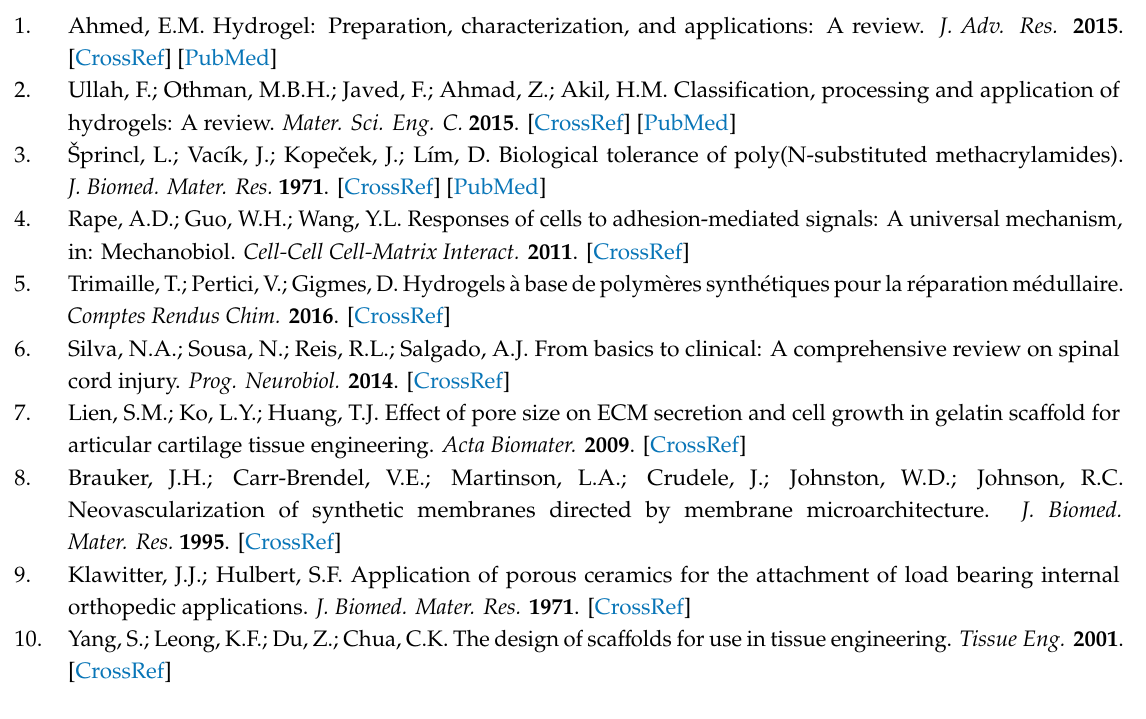
Figure S1: Examples of the evaluation of size of pores determined using the ImageJ